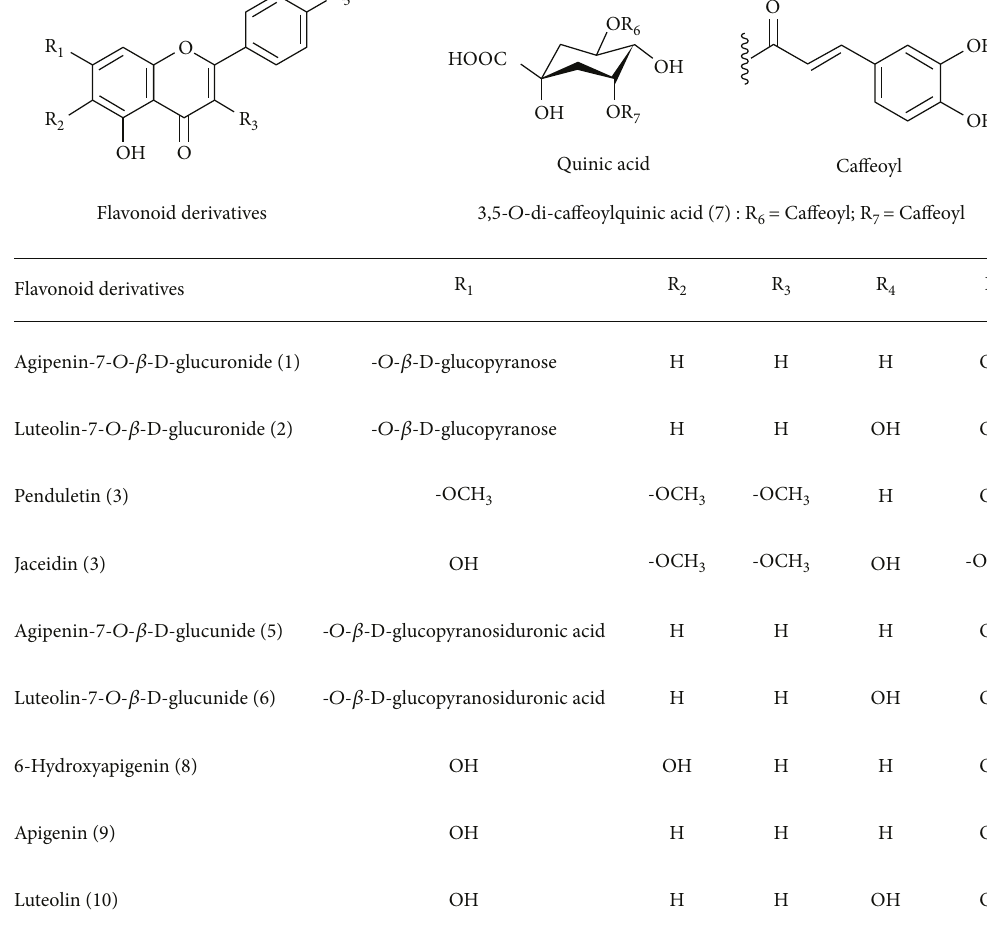
Figure 2: The chemical structures of compounds isolated from Matricaria recutita